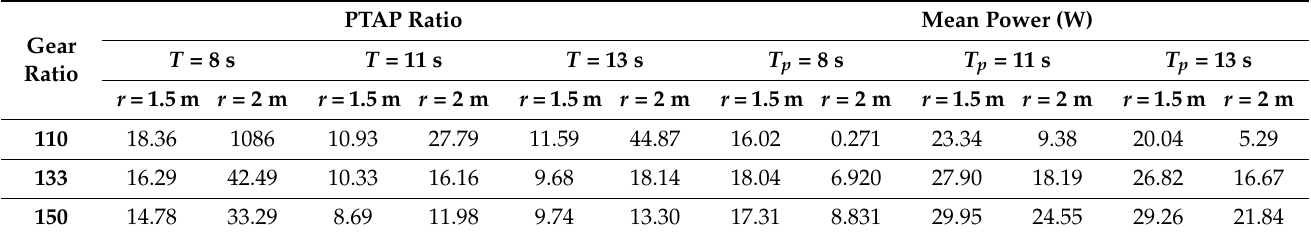
Table 5. PTAP ratio and mean power for an irregular wave with a fixed-significant wave height ( H s = 2.5 m). Gear